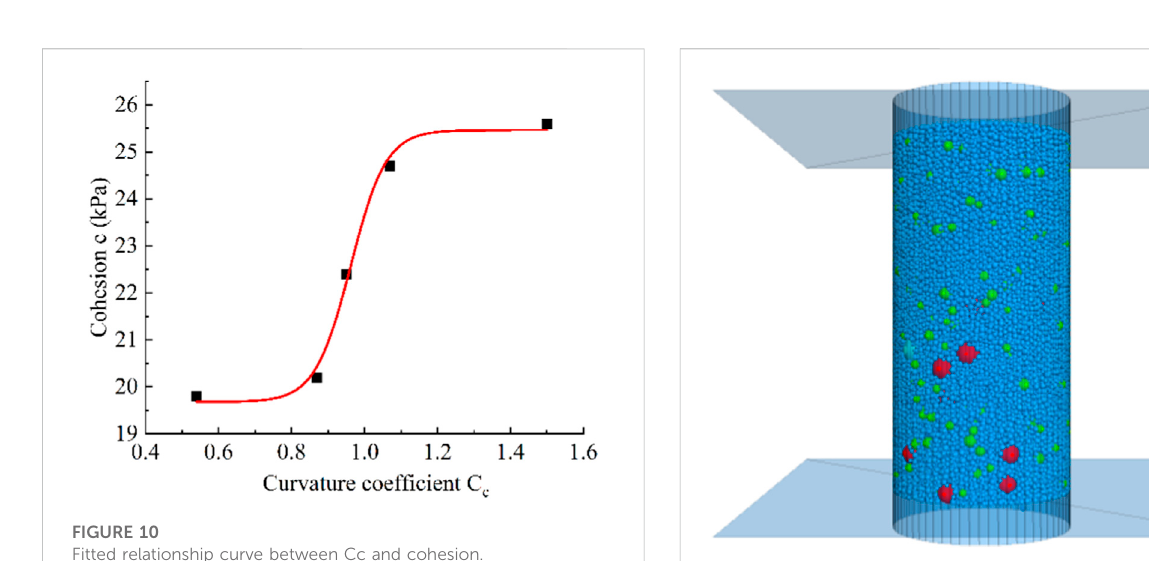
FIGURE 12 Numerical